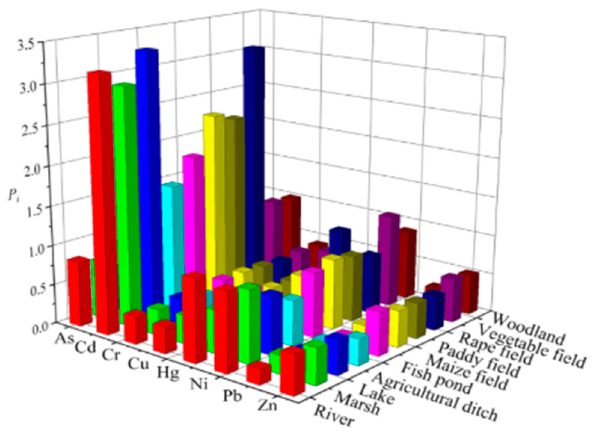
Figure 3. Single pollution index ( P i ) of heavy metals in di ff erent landuse types in Huixian wetland, colors representing landuse